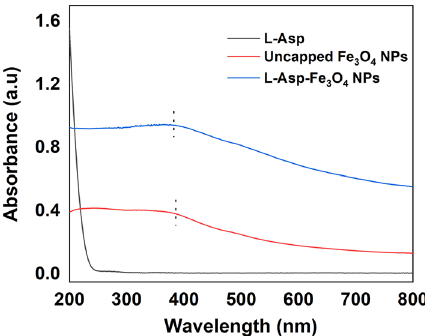
Fig. 1 The UV–Visible absorption spectra of L-Aspartic acid, uncapped Fe 3 O 4 NPs, and L-Asp capped Fe 3 O 4 NPs